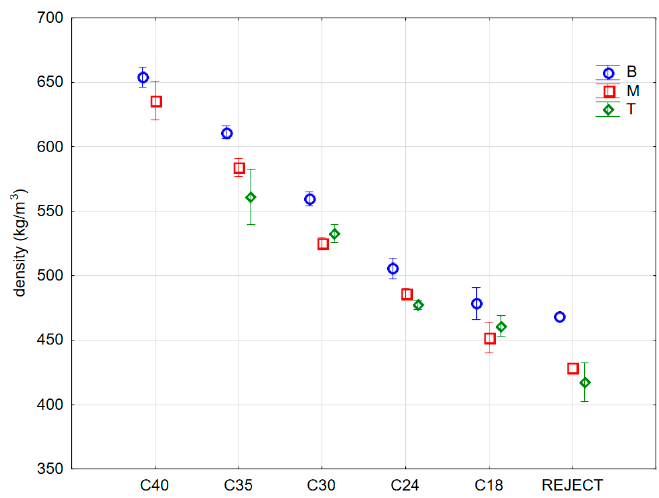
Figure 3. Density distribution within timber strength classes.